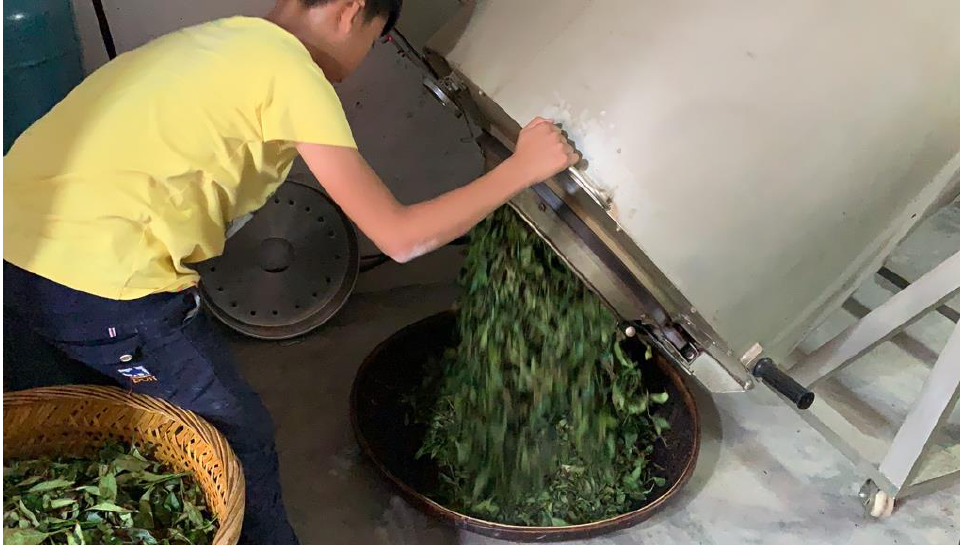
Figure 2. Tea farmer’s son learning how to process tea. Source: photograph by the first author .